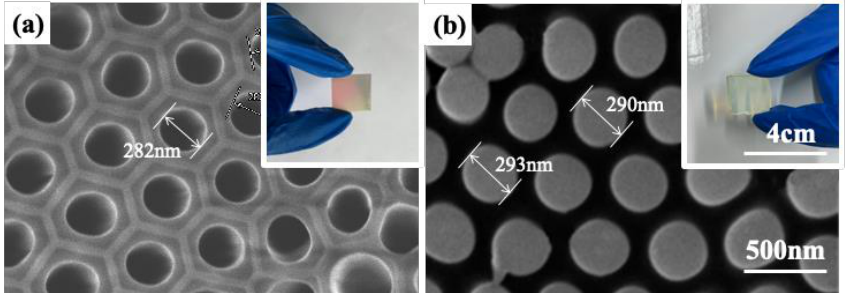
Figure 2. SEM images of the anodic aluminum oxide (AAO) template and the as-constructed nano-pillar structured EP surface ( d = 290 nm): ( a ) AAO template; ( b ) nano-pillar EP array.